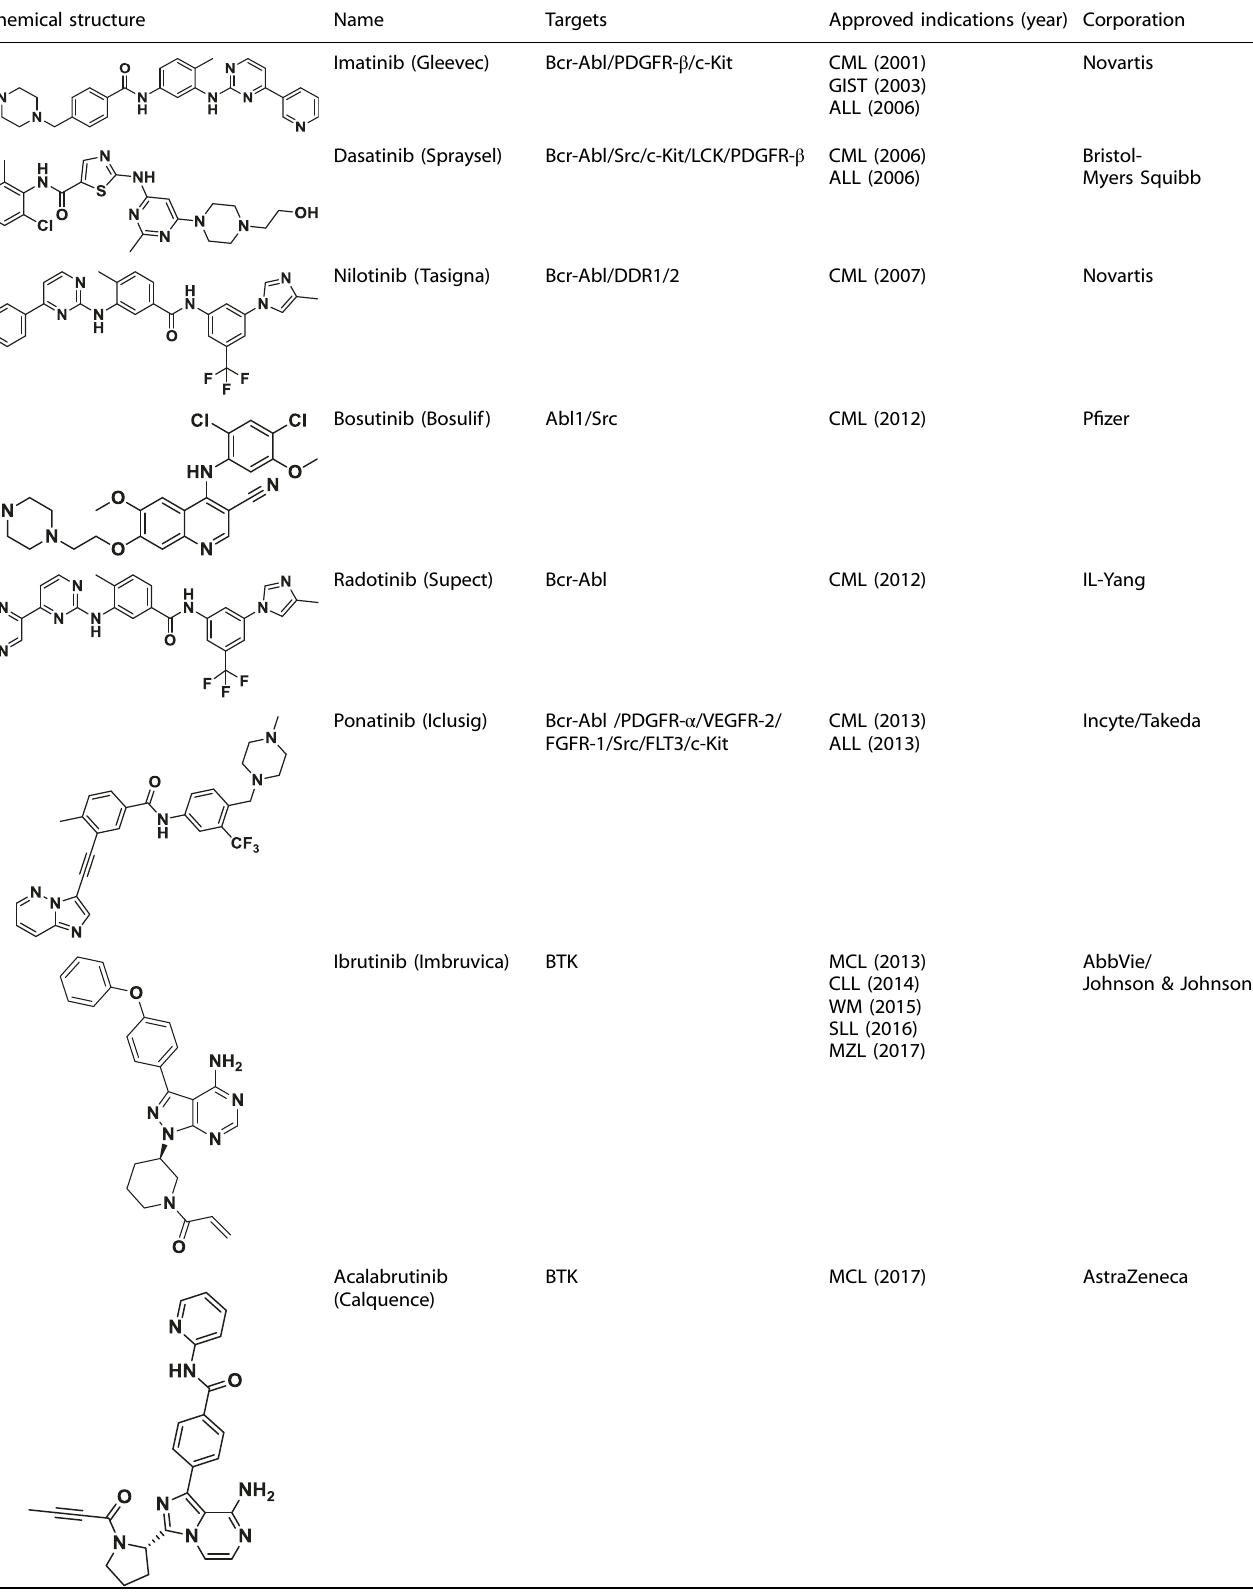
Table 2. Properties of approved small-molecule inhibitors of non-receptor tyrosine kinases Chemical